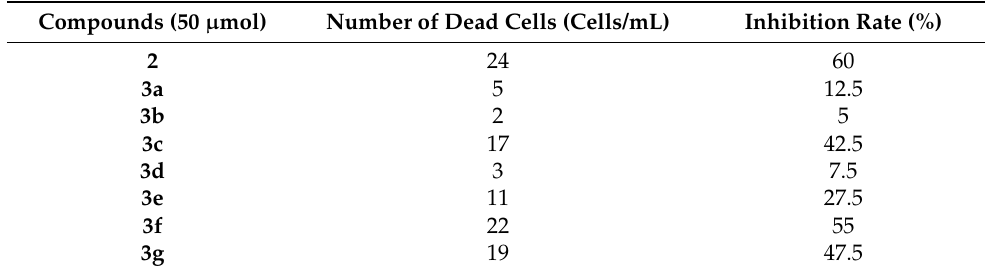
Table 4. The MTT assay of compounds 2 and 3a – g